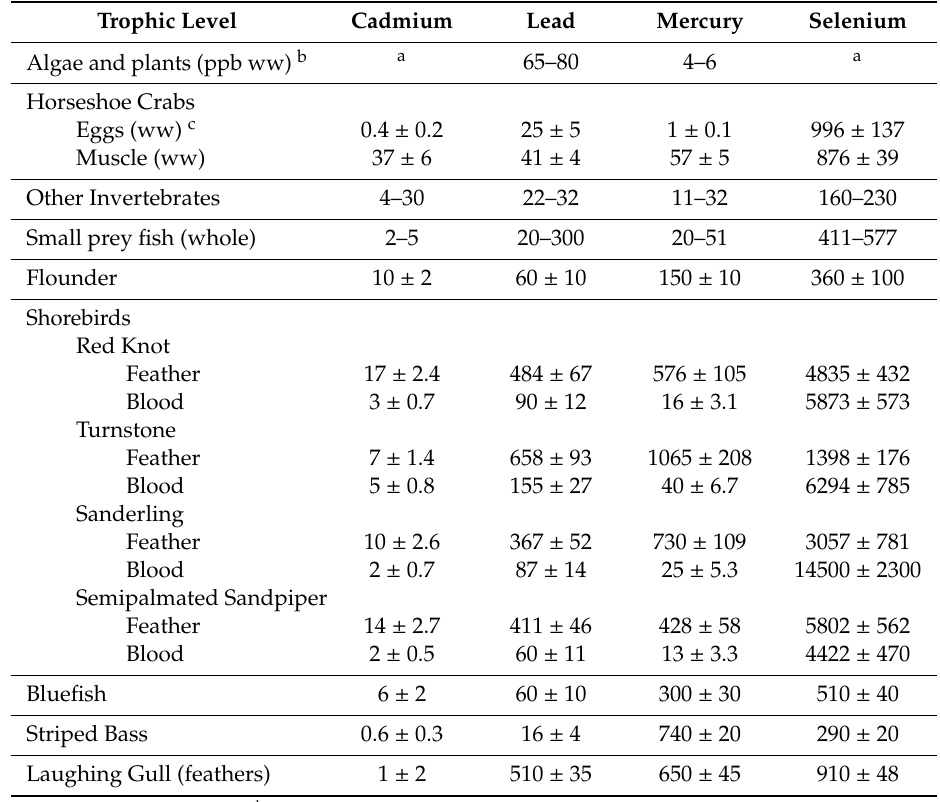
Table 1. Metal levels in some key organisms of the food chain in Delaware Bay, New Jersey. Given are range of means (or mean ± SE) (after Burger and Gochfield [9,52]; Tsipoura et al. [33]; Burger et al. ([35,53,56,57], unpublished data); Burger and Tsipoura [43]; Burger [51]; and Gochfeld et al.